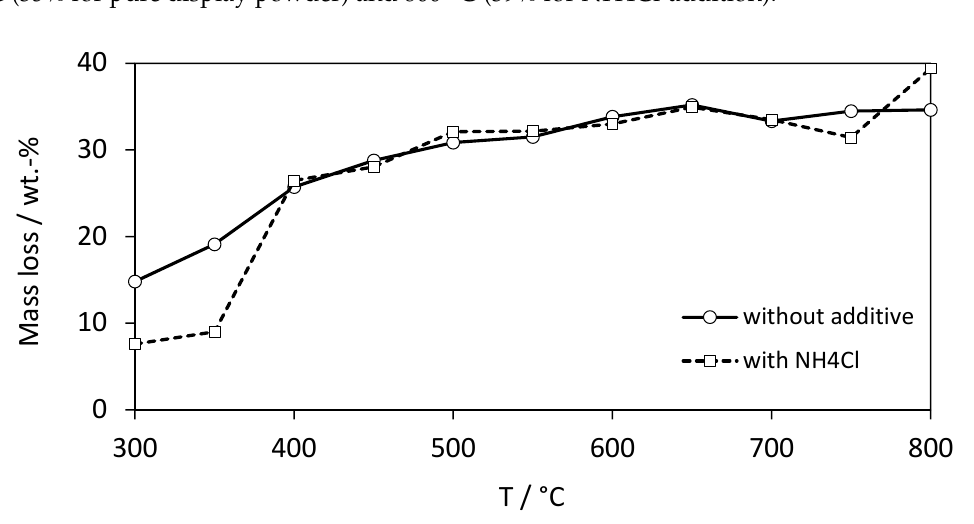
Figure 3. Mass loss during the pyrolysis of ground smartphone displays.